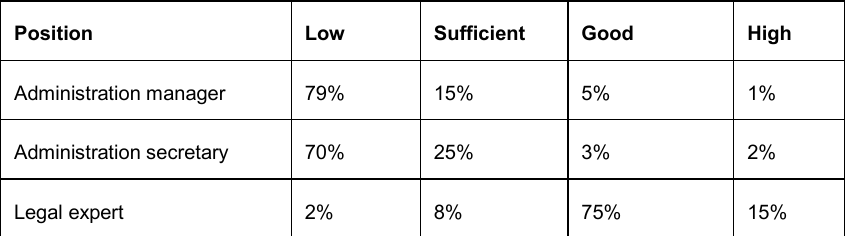
Table 2. Opinion of experts: percentage of correspondence for the three considered work